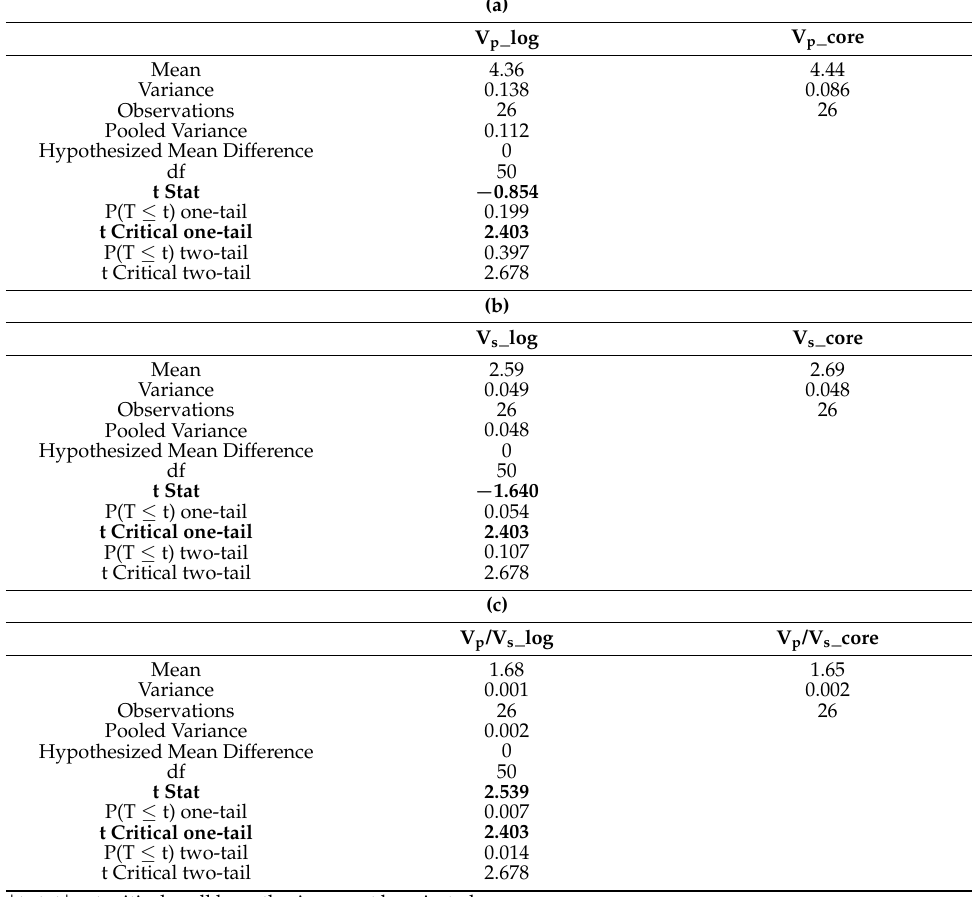
Table 10. (a) Student t -test for the sonic log and ultrasonic core P-wave velocity measurements (after fluid substitution to in situ saturations; with the very unlikely assumption that Laboratory S g = 0) for all four formations combined. The results indicate there is no significant difference between the mean of the sonic log and ultrasonic core measurements. (b) Student t -test for the sonic log and ultrasonic core S-wave velocity measurements (after fluid substitution to in situ saturations; with the very unlikely assumption that Laboratory S g = 0) for all four formations combined. The results indicate there is no significant difference between the mean of the sonic log and ultrasonic core measurements. (c) Student t -test for the sonic log and ultrasonic core V p /V s ratio measurements (after fluid substitution to in situ saturations; with the very unlikely assumption that Laboratory S g = 0) for all four formations combined. The results indicate that we cannot conclude that there is no significant difference between the mean of the sonic log and ultrasonic core velocity